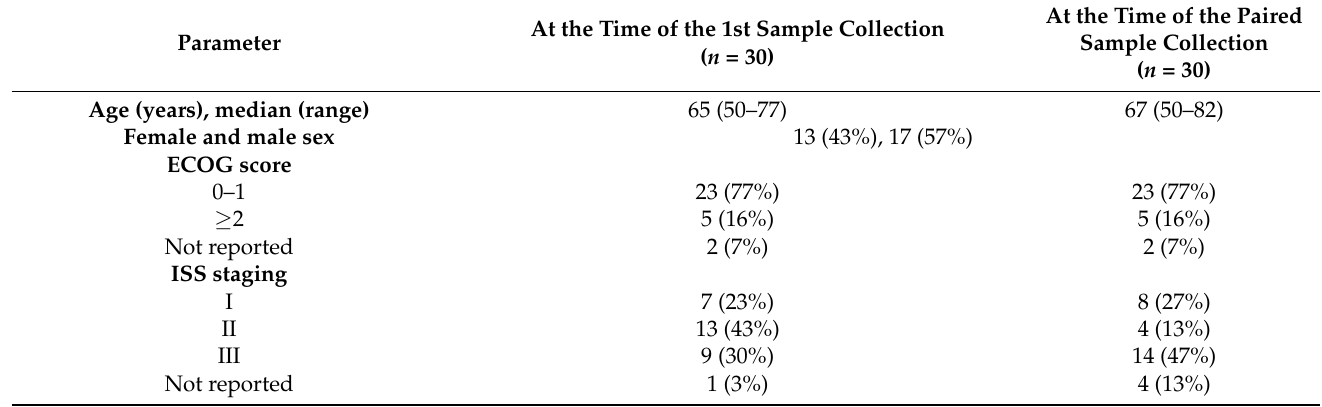
Table 1. Patient and disease